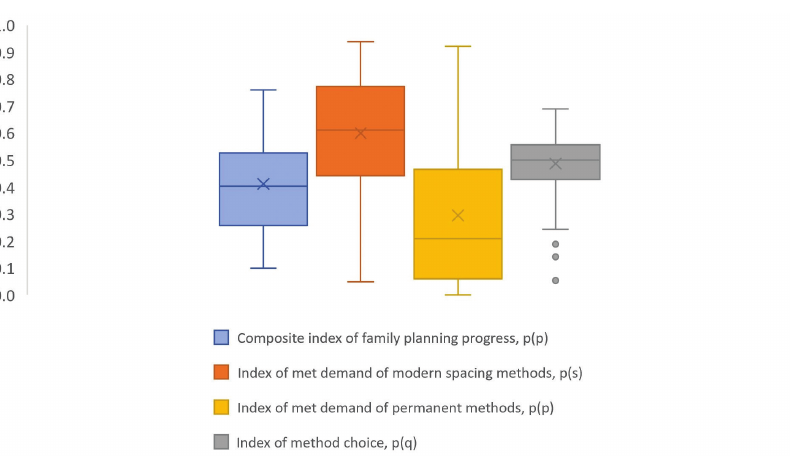
Figure 1: Inter-country Variation in Different Indexes of Family Planning Across 113